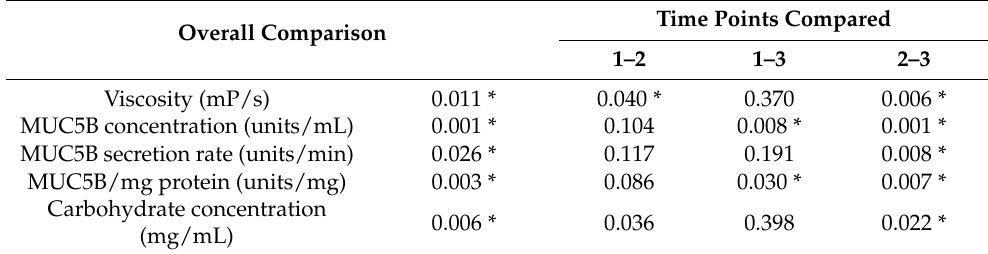
Table 2. Effect of exercise on the composition of saliva: comparison of different time points. Parameters that showed significant changes according to the overall comparison with Friedman test were post-hoc pairwise compared with the Wilcoxon test. Time Points Compared Overall Comparison 1–2 1–3 2–3 Viscosity (mP/s) 0.011 * 0.040 * 0.370 0.006 * MUC5B concentration (units/mL) 0.001 * 0.104 0.008 * 0.001 * MUC5B secretion rate (units/min) 0.026 * 0.117 0.191 0.008 * MUC5B/mg protein (units/mg) 0.003 * 0.086 0.030 * 0.007 * Carbohydrate concentration 0.006 * 0.036 0.398 0.022 (mg/mL)